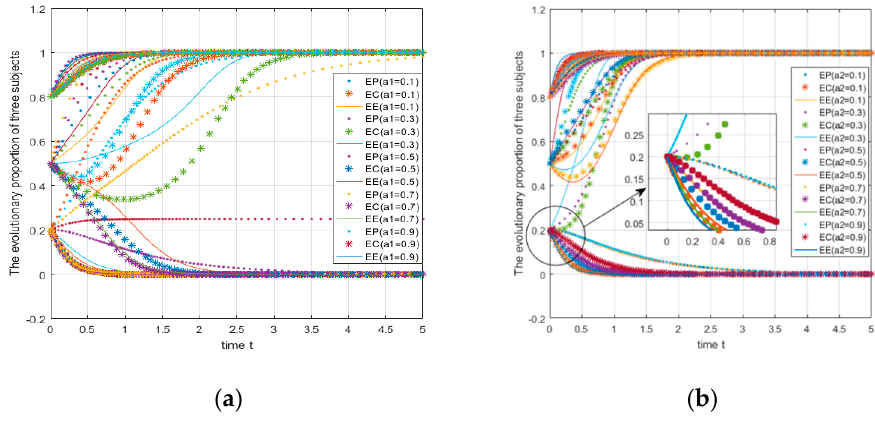
Figure 9. Impact of changes in the subsidy’s proportional coefficient on system evolution.